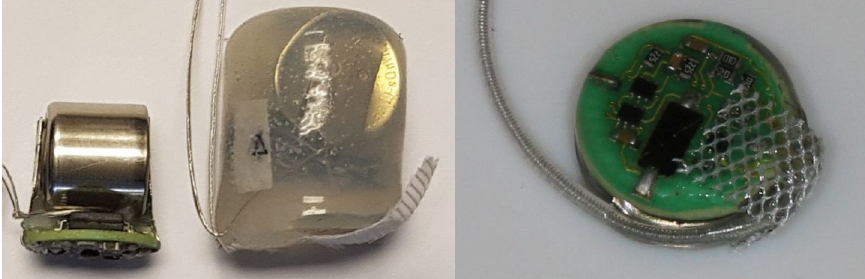
Fig 3. Left: MiniVStimA170 (DL1/3N battery). Middle: MiniVStimA170 encapsulated in silicone. Right: MiniVStimA35 (CR1220 battery) encapsulated in Expoxy Resin with attached electrodes.